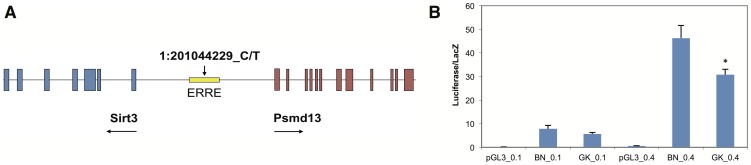

Sirt3 promoter variant and luciferase assay.(A) Bidirectional promoter of Sirt3 and Psmd13. One single nucleotide polymorphism (1:201044229_C/T) was identified when comparing sequence of GK promoter with BN. (B) Luciferase reporter assay results for transfection of hepatoma cell line. BN or GK allele of Sirt3 promoter was cloned into pGL3-basic vector upstream of luciferase gene, and transfected into Hep3B cells at two levels, 0.1 and 0.4 ug/well. Results are corrected for transfection efficiency by co-transfection with beta-galactosidase vector, and represent two-three independent transfections, which were run in triplicate wells.